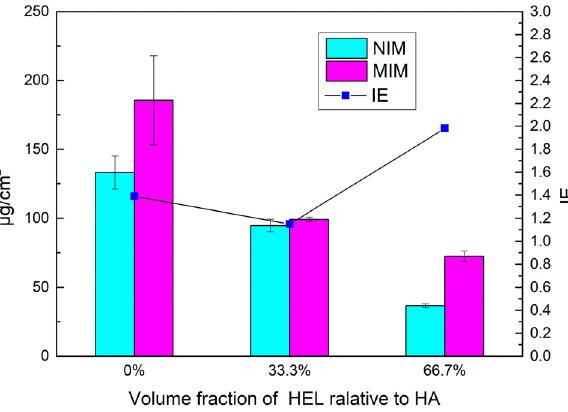
Figure 13: Adsorption capacities and imprinting e ffi ciency of dif - ferent volume fractions of HEL relative to HA.